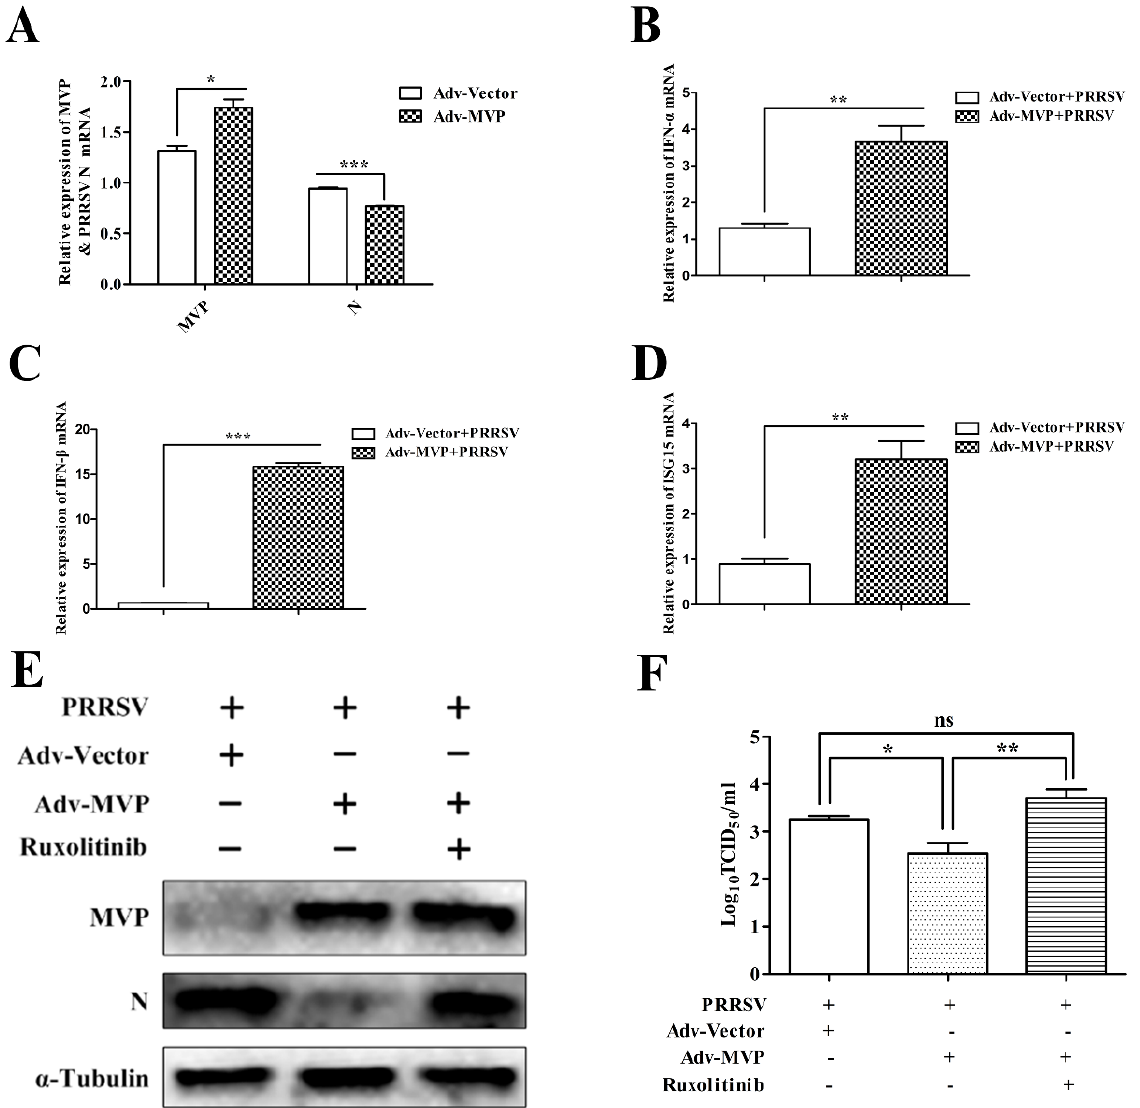
Figure 6. The anti-PRRSV activity of MVP was mediated by type Ⅰ IFNs. PAMs were infected with Adv − Vector or Adv − MVP (MOI = 5) for 12 h. Subsequently, cells were infected with GD-HD PRRSV (MOI = 0.1) for 24 h. The mRNA expression levels of MVP, PRRSV N ( A ), IFN- α ( B ), IFN- β ( C ) and ISG15 ( D ) were detected by qPCR. GAPDH was used as an internal loading control in qPCR analysis. ( E , F ) PAMs were infected with Adv − Vector or Adv − MVP (MOI = 5) for 2 h and subsequently treated with ruxolitinib (5 μ M) for 12 h. After infection with GD-HD PRRSV (MOI = 0.1) for 24 h, the protein expression levels of MVP and PRRSV N were detected by Western blot ( E ). Virus titers from cell supernatants were measured by TCID 50 ( F ). The α -tubulin was used as an internal loading control in Western blot analysis. Data from three independent experiments are expressed as the means ± SD. Analysis of differences between the means was performed using Student’s t -tests or ANOVA and is marked by ns (no significant), * ( p < 0.05), ** ( p < 0.01) and *** ( p <